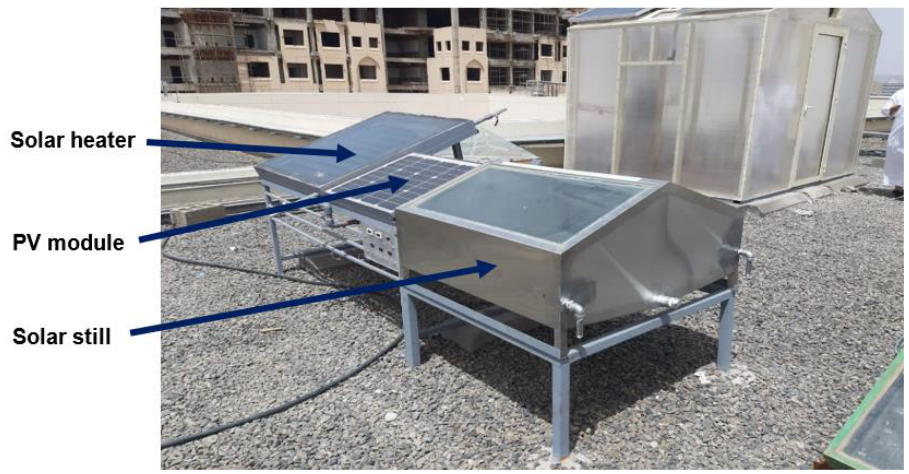
Figure 2. A photo of the designed smart hybrid solar heater–solar still system.